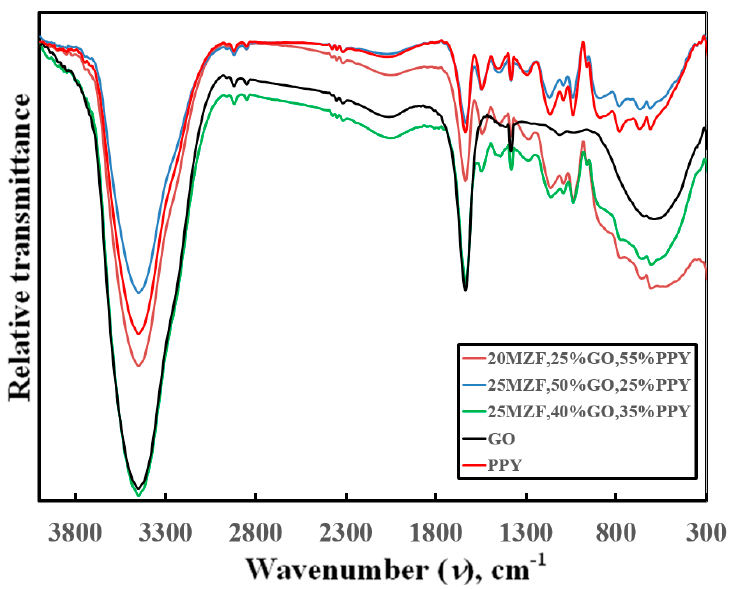
Figure 2. FT-IR spectra of graphite oxidation product, pure PPy, and PMG composites with different ratios.